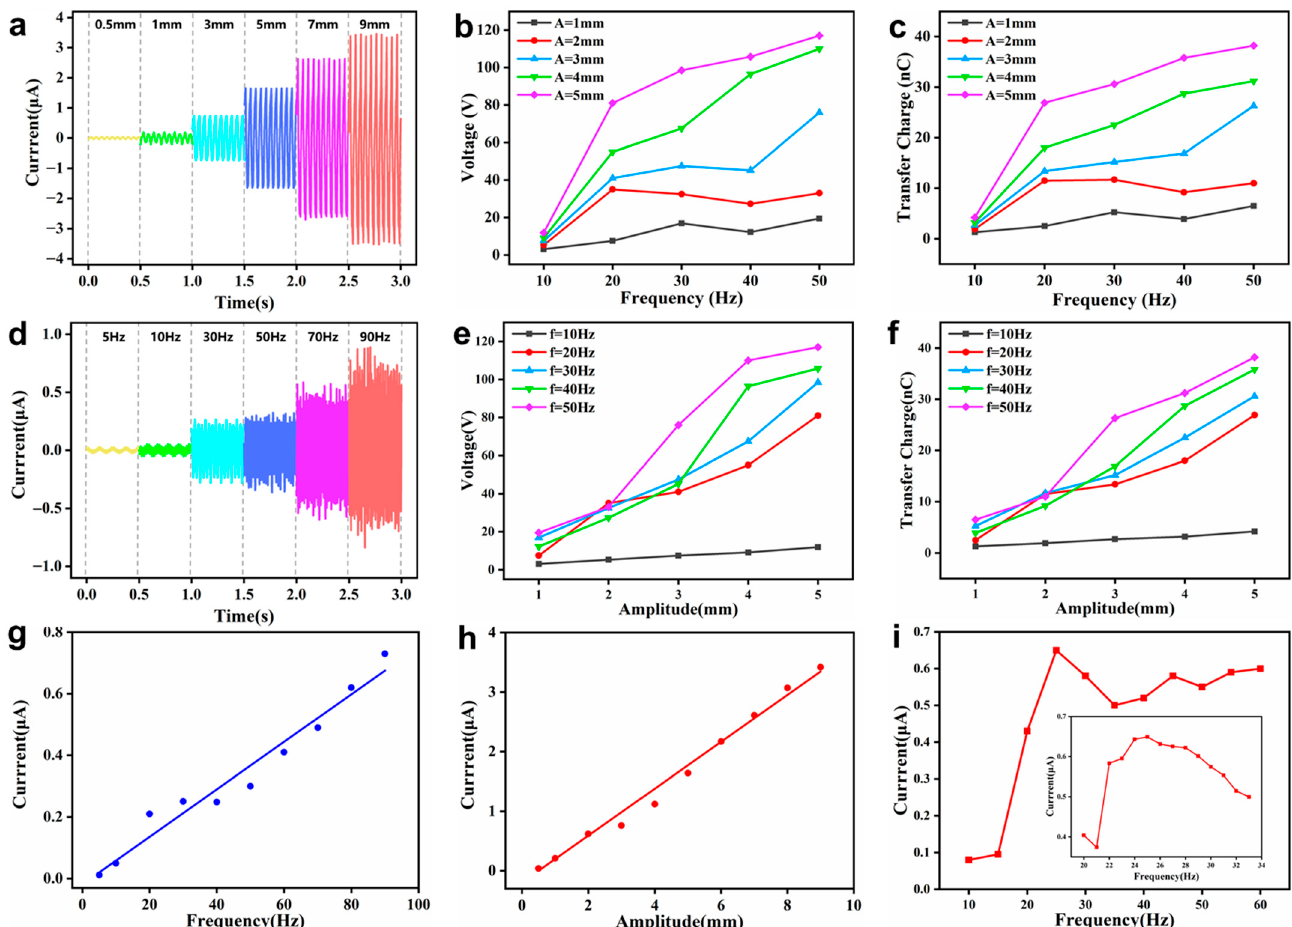
Figure 4. Electrical output performance of the SRS-TENG. ( a ) Short-circuit current with different vibration amplitudes under a vibration frequency of 20 Hz. ( b ) Open-circuit voltage and ( c ) trans- ferred charge with different vibration amplitudes under different fixed frequencies. ( d ) Short-circuit current with different vibration frequencies under a vibration amplitude of 1 mm. ( e ) Open-circuit voltage and ( f ) transferred charge with different vibration frequencies under different fixed ampli- tudes. ( g ) Linear relationship between the short-circuit current and vibration frequency at a fixed vibration amplitude of 1 mm. ( h ) Linear relationship between the short-circuit current and different vibration amplitude at a fixed vibration frequency of 20 Hz. ( i ) Short-circuit current under a vibration acceleration of 20 m/s 2 .